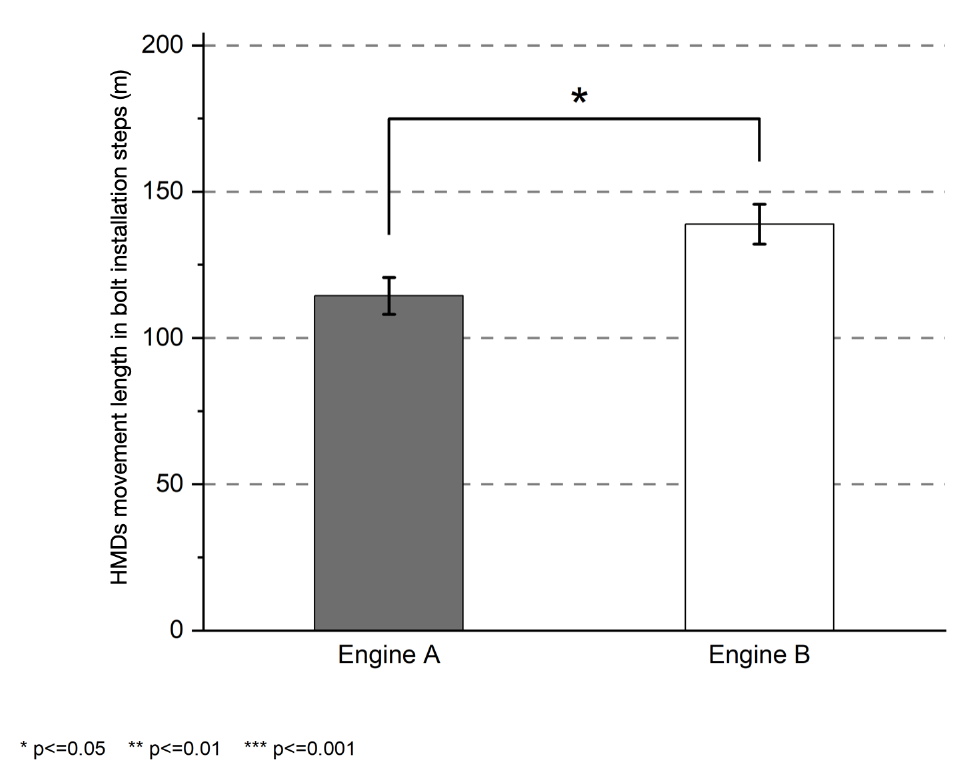
Figure 46. The movement distance of HMDs in bolt installation.